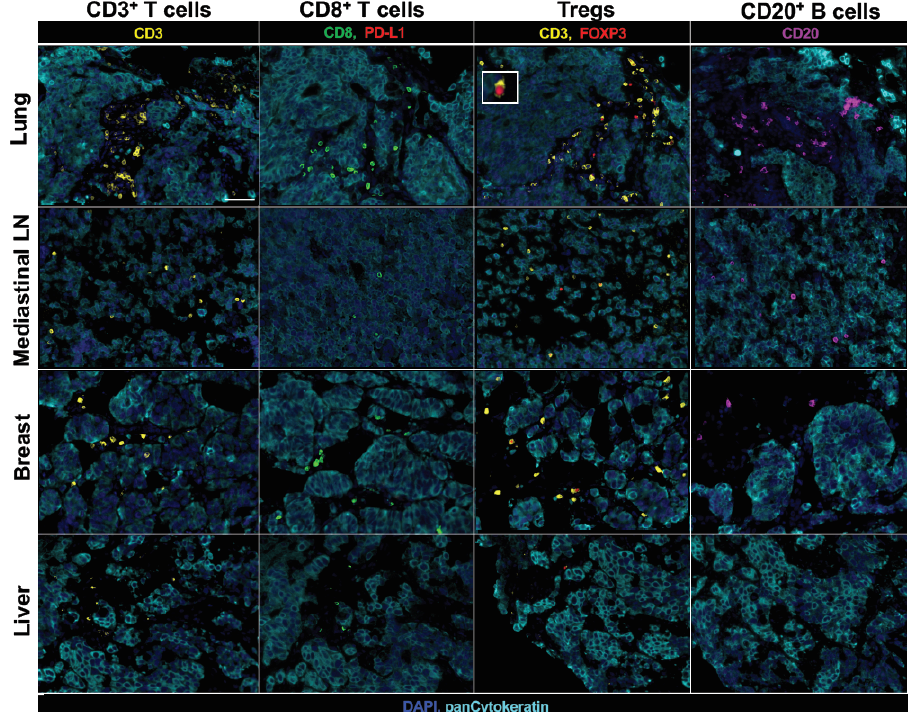
Figure 3. Multiplex fluorescent immunohistochemistry results. Representative images of lung, mediastinal LN, breast and liver tumors are shown. Formalin-fixed paraffin-embedded sections of each tumor were stained with one of three sequences of primary antibodies, CD3 (yellow), CD8 (green) and PD-L1 (red), CD3 and FOXP3 (red), or CD20 (purple). All sequences were also included with pan-Cytokeratin (light blue) for staining tumor cells, and nuclei were counterstained with DAPI (blue). PD-L1 expression was not identified in all tumors. The inserted panel in left upper of a representative lung tumor Treg image shows a Treg cell at high magnification. Scale bars, 50 µm, are shown in CD3 + T cells of lung tumor panel.